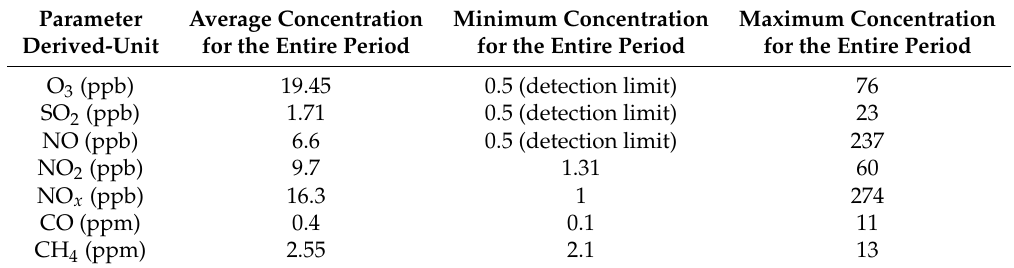
Table 1. Average, minimum and maximum concentrations of the parameters derived.